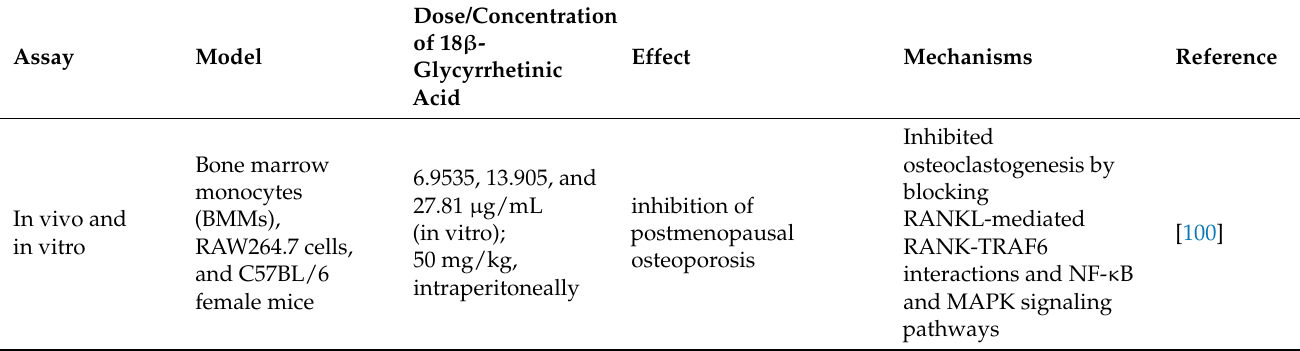
Table 4. Management of postmenopausal osteoporosis, osteoarthritis, antipsychotic-induced hyper- prolactinemia, multiple sclerosis, and inflammation and mechanisms of 18 β -glycyrrhetinic acid in in vitro and in